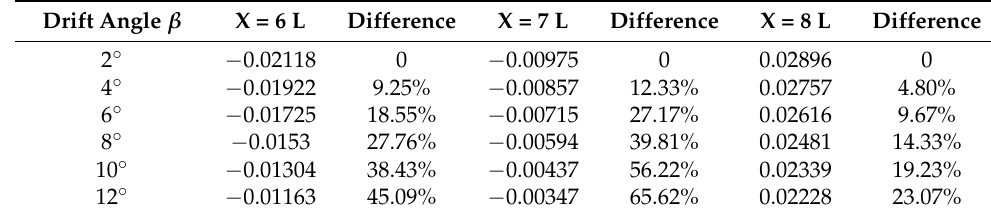
Table 6. Wave height value